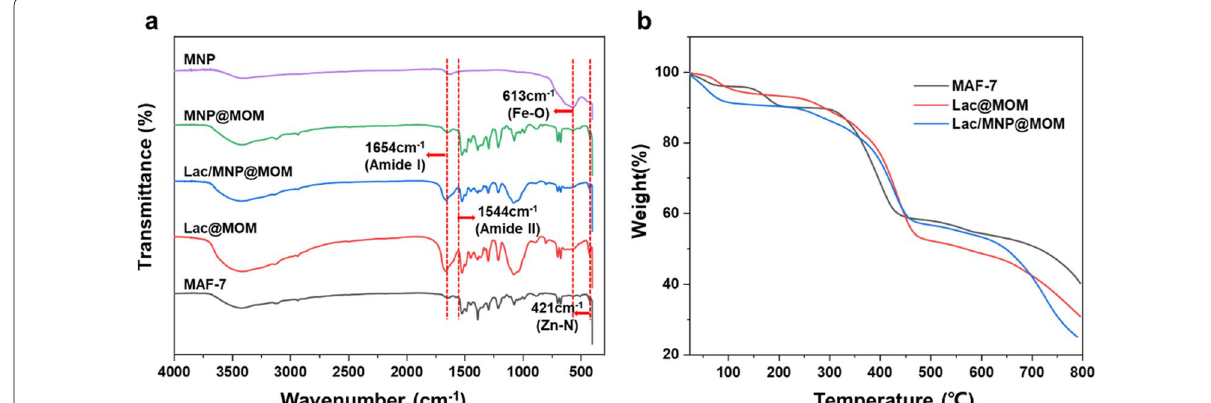
Fig. 2 a FT-IR spectra of MAF-7, Lac@MOM, Lac/MNP@MOM, and MNP@MOM; b TGA curves of MAF-7, Lac@MOM, and Lac/MNP@MOM